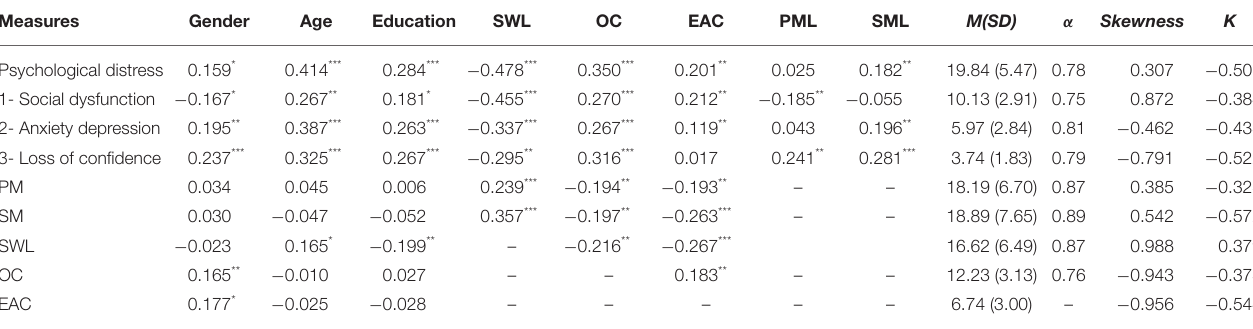
TABLE 1 | Relationship and descriptive characteristics of study variables. Measures Psychological distress 0.159 *